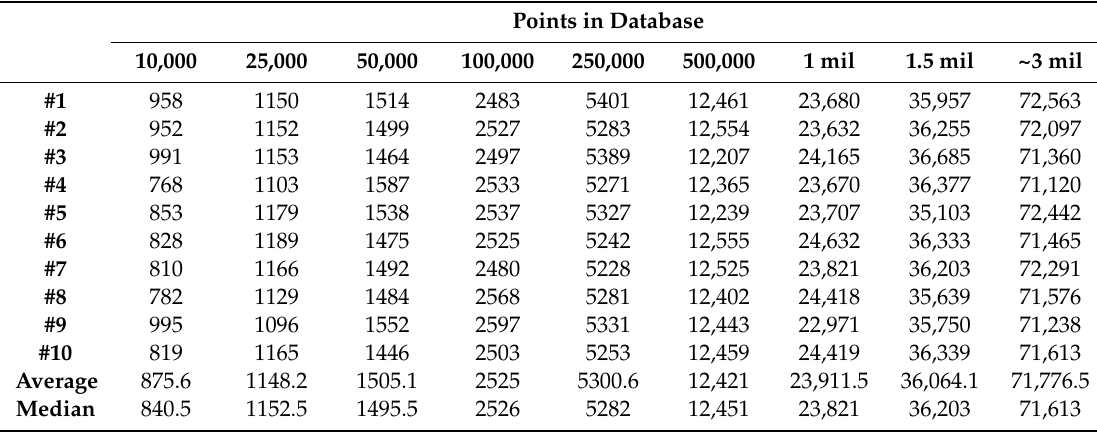
Table 4. Results of testing Supercluster library (values in milliseconds).